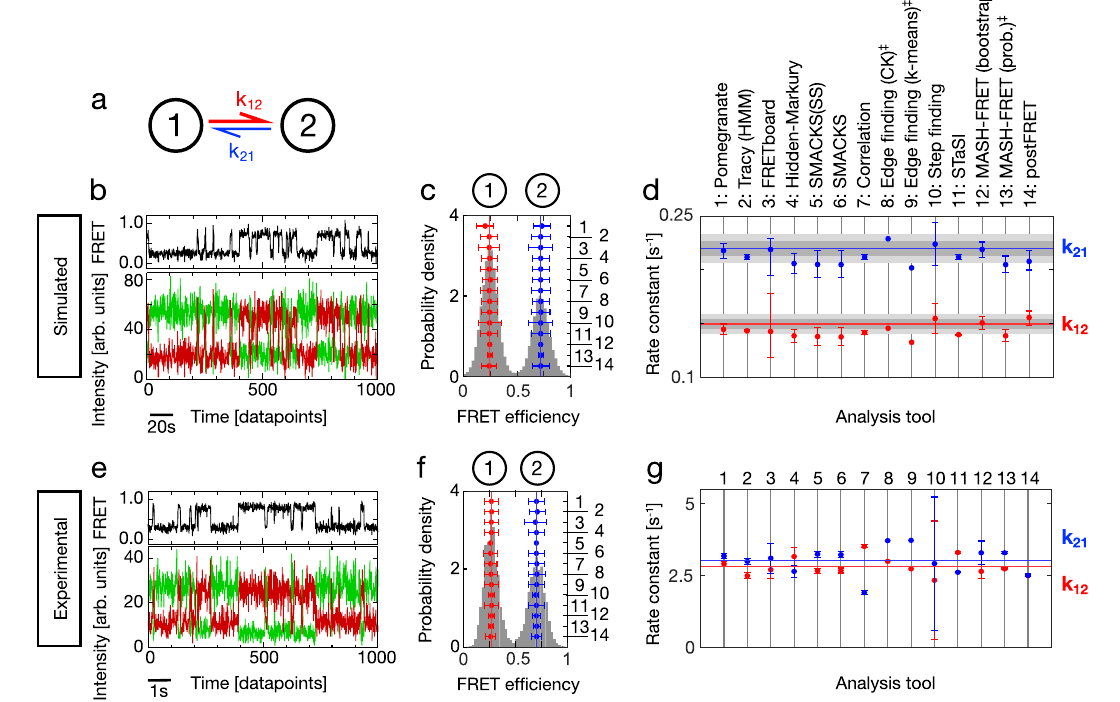
Fig. 2 | Quanti fi cation of simulated and experimental kinetics between two states. a Illustration of the kinetic model with two states (circles) connected by forwardandbackwardrateconstants:k 12 andk 21 . b AsimulatedFRETtraceshowing the donor and acceptor fl uorescenceintensity (green, red)and the FRETef fi ciency (FRET, black), representative for the dataset used in ( c , d ): n(traces)=75, n(data- points)=59,486, sampling rate=5Hz, time per datapoint=200ms. c FRET ef fi - ciency histogram (gray) with assigned states on top and inferred FRET ef fi ciencies inredandblue.Numbersontherightaxisrefertotheanalysistoolsspeci fi edin( d ). Vertical lines indicate the mean over all tools. Sample size as in ( b ). The error bars representstandarddeviations. d Rateconstantsanduncertaintiesinferredfromthe dataset in c by different labs using the respective analysis tools. The ground truth (GT) is indicated by horizontal red and blue lines, the intrinsic uncertainty of the dataset (see text) is represented by dark gray (1 σ ) and light gray (2 σ ) intervals. Sample size as in ( b ). Uncertainty measures (CI, SD) as listed in Table 1. e